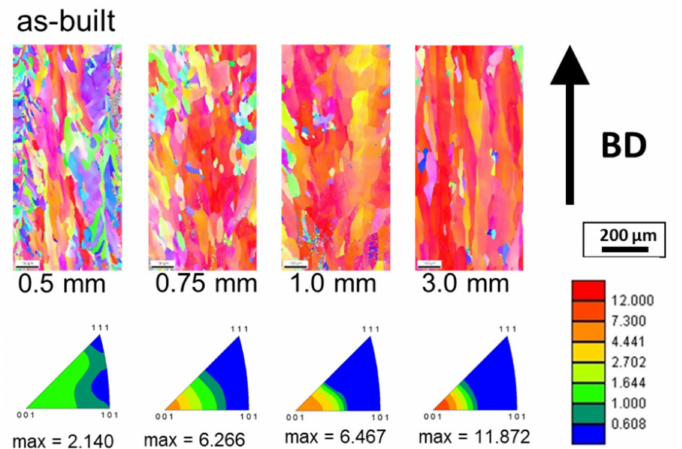
Figure 2. Electron backscatter diffraction (EBSD) inverse pole figure (IPF) maps of additively manu- factured Fe-Mn-Al-Ni samples plotted in build direction (BD) for diameters ranging from 0.5 mm to 3 mm for the as-built condition ( a – d ). BD indicates the build direction. The color-coded triangles reveal the maximum texture. The relevant legend coding texture intensity is shown on the right side (max.